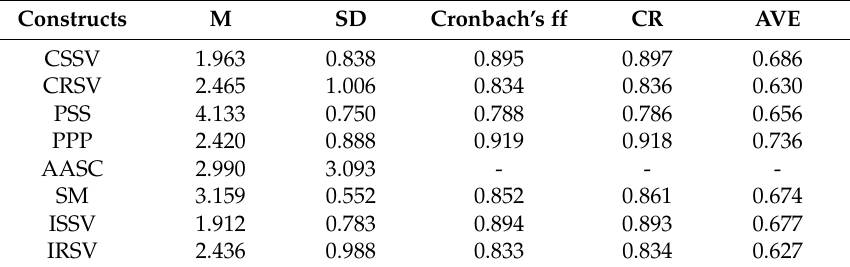
Table 3. Descriptive statistics, construct reliability, and convergent validity.